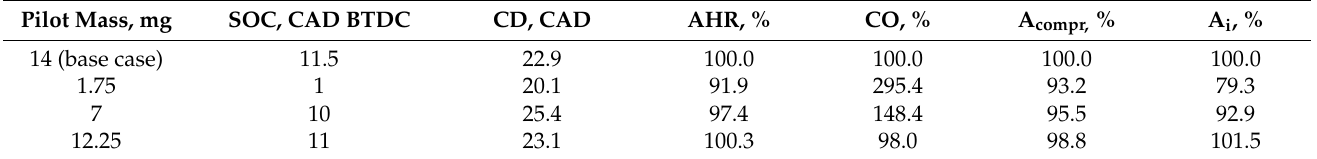
Table 4. Combustion parameters for the pilot injection fuel mass